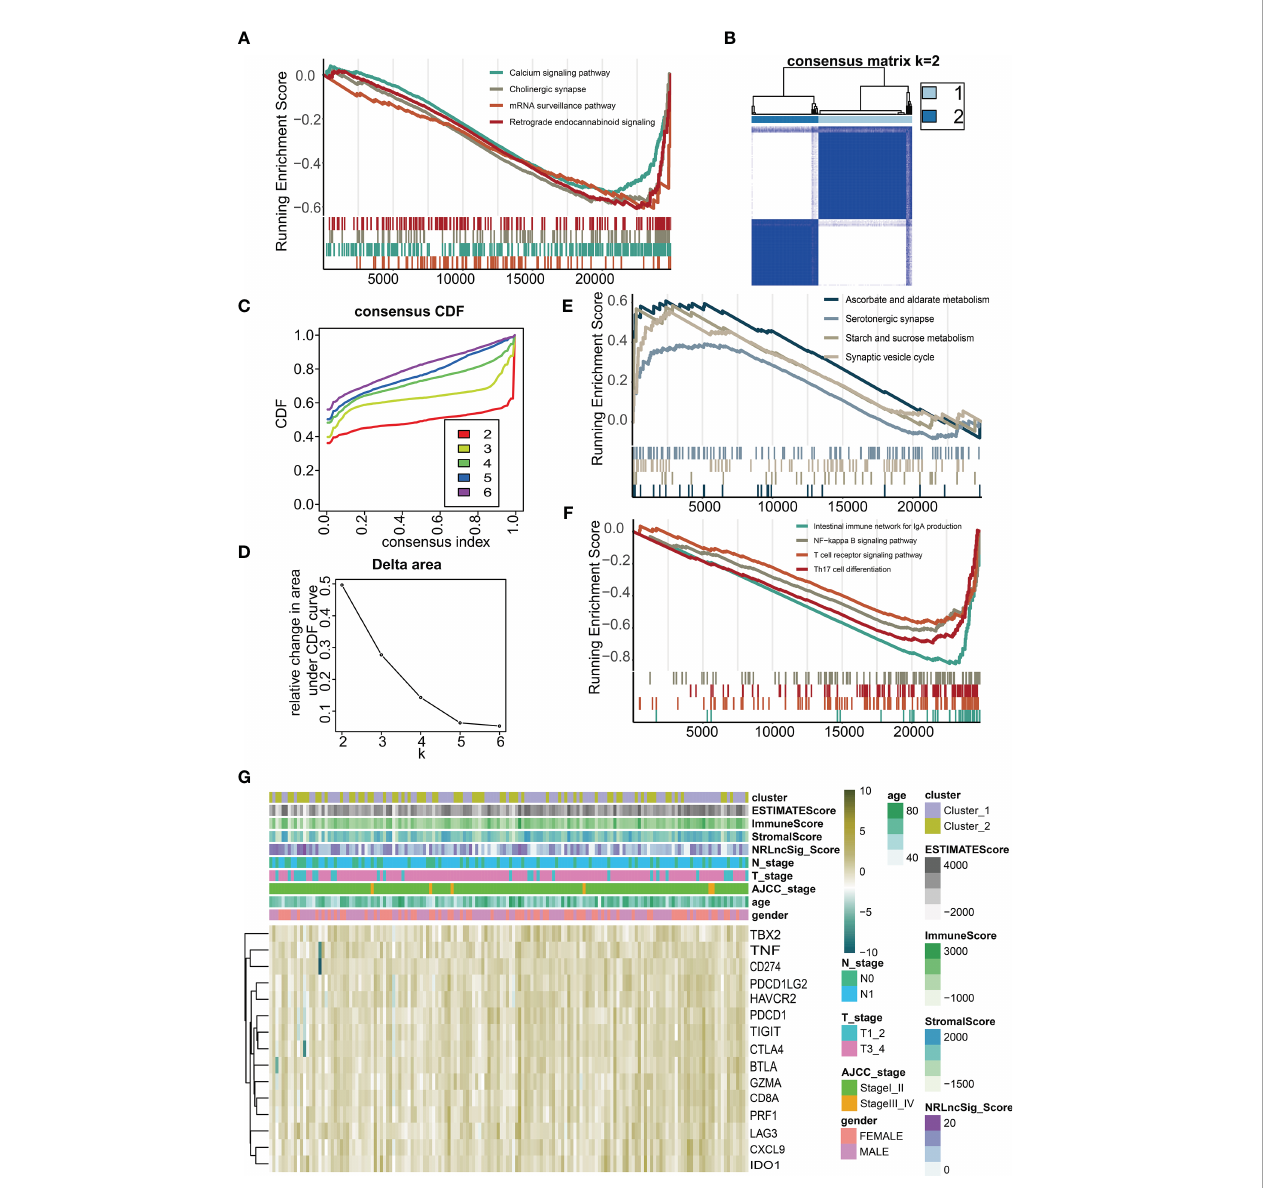
FIGURE 9 Immune microenvironment of different immune subtypes. (A) Gene set enrichment analysis (GSEA) for NRS Score. (B) Two immune subtypes were identi fi ed by unsupervised consensus clustering based on K-means. (C) Consensus values range from 0 to 1. (D) The corresponding relative change in area under the cumulative distribution function (CDF) curves. The range of k changed from 2 to 6, and the optimal k = 2. (E, F) Gene set enrichment analysis (GSEA) for immune subtypes. (G) Heatmap of the expression of immune checkpoints under different immune subtypes and immune